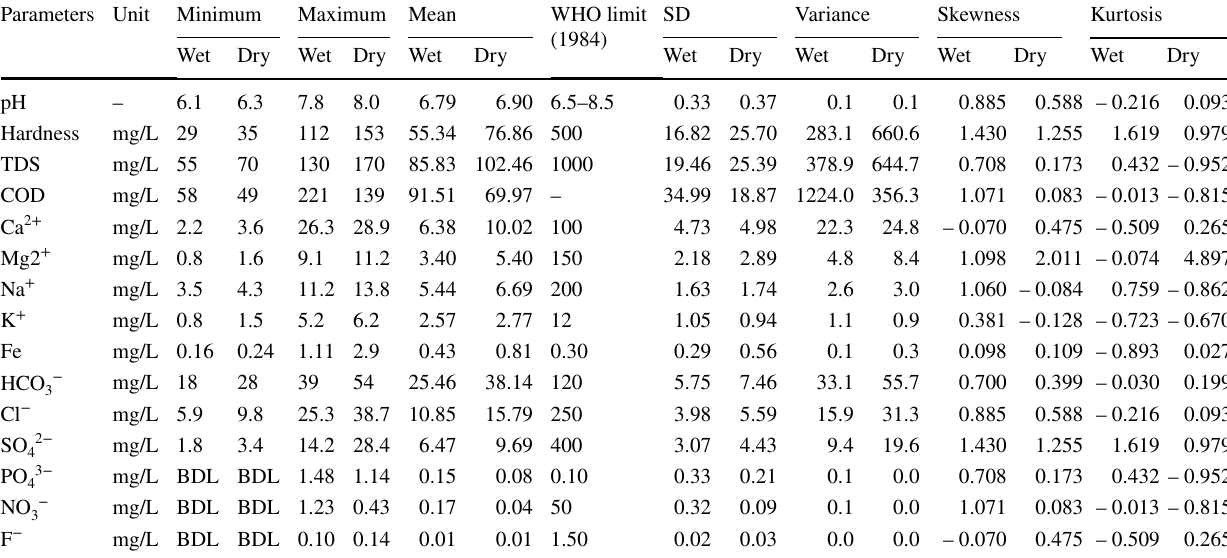
Table 2 Descriptive physicochemical characteristics of surface water sources in both the wet and dry seasons (BDL: below detection limit) Parameters Unit